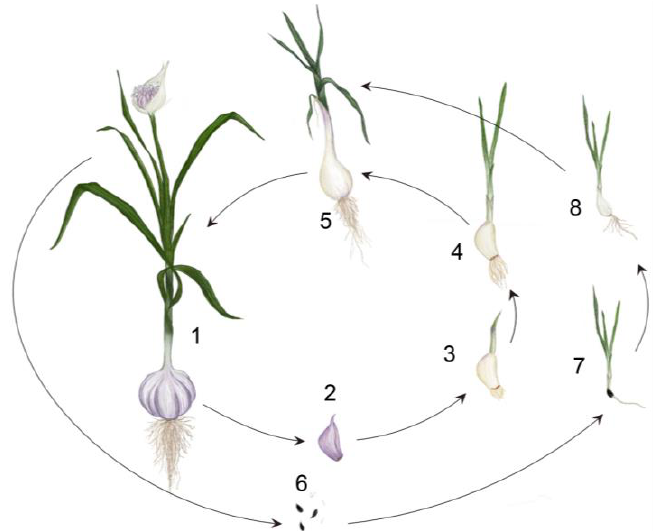
Figure 1. Life cycle of a garlic plant showing the different stages from the germination of a seed or clove to a mature plant. (1) Adult garlic plant of a bolting cultivar bearing a floral scape. (2) Dormant clove, recently detached from the mother plant, which has not yet produced adventitious roots. (3) Sprouted clove in which new adventitious roots and the first leaves have emerged. (4) Young garlic plant in which the formation of new cloves has not yet been initiated. (5) Garlic plant in which the bulb is actively thickening as a result of the growth of new cloves. (6) True seeds are produced only in some fertile garlic varieties. (7) When a seed germinates, a new seedling emerges, with a primary root emerging from the embryo ’ s apical meristem and new leaves developing from the shoot apical meristem. (8) Under inductive conditions, seed-derived plants can also produce new bulbs, which can then be vegetatively propagated if desired.